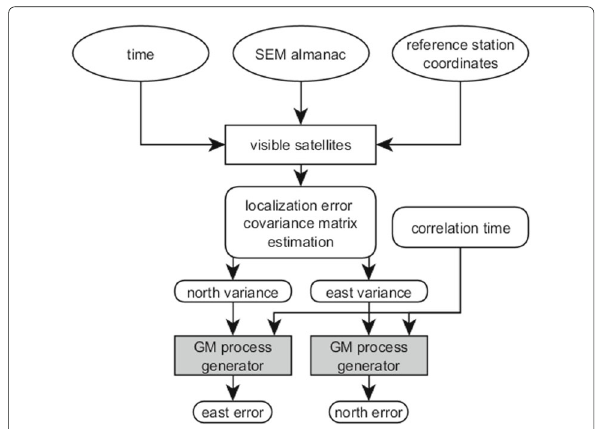
Fig. 20 Block diagram of the RTK localization error generator